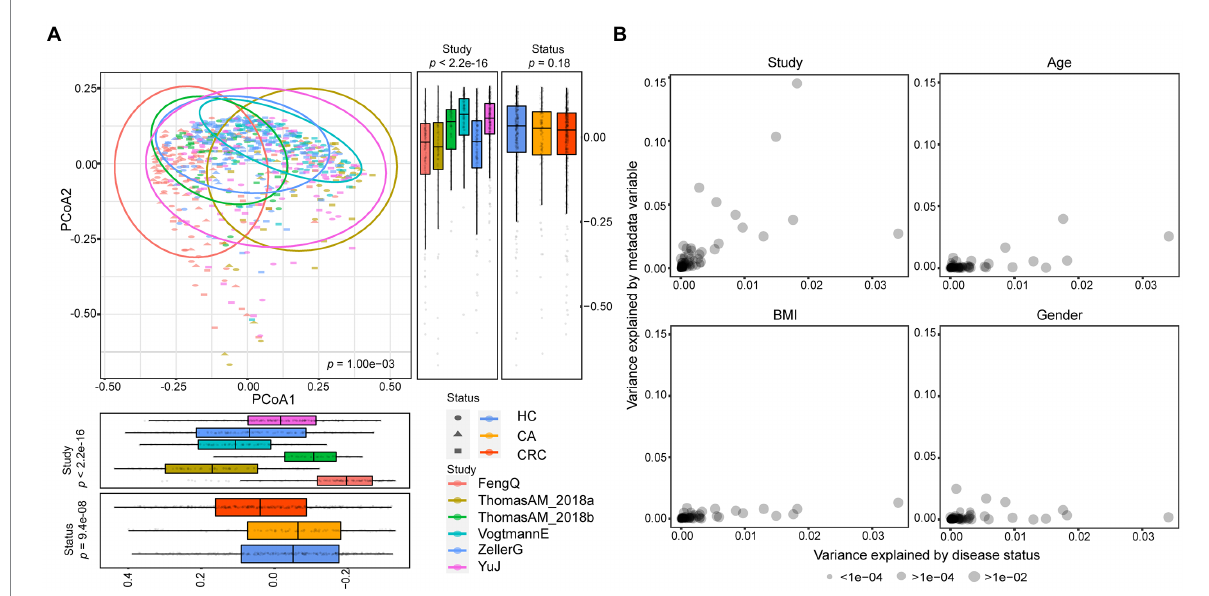
FIGURE 1 Comparison of heterogeneity between different studies. (A) A strong influence of study heterogeneity on beta diversity. PCoA analysis of samples from six metagenomic sequencing studies based on Bray–Curtis distance showed the fecal microbiota composition was different among studies ( p < 0.001) and groups ( p < 0.001). Studies were color-coded and groups (HC, CA, and CRC) were indicated by different shapes. The upper-right and the bottom-left boxplots illustrated that samples were projected onto the first two principal coordinates broken down by study and disease status, respectively. (B) The associations of potential confounding factors of individual microbial species with patient geographic and technical factors. Variances explained by disease status (CRC versus CA or HC) were plotted against variances explained by different confounding factors, including age, gender and BMI. Each species was represented by a dot proportional in size to its abundance; For the confounder analysis, the BMI was split into lean/normal/overweight/obese according to cutoffs (thin: <20; normal: 20–25; overweight: 25–30; obese: